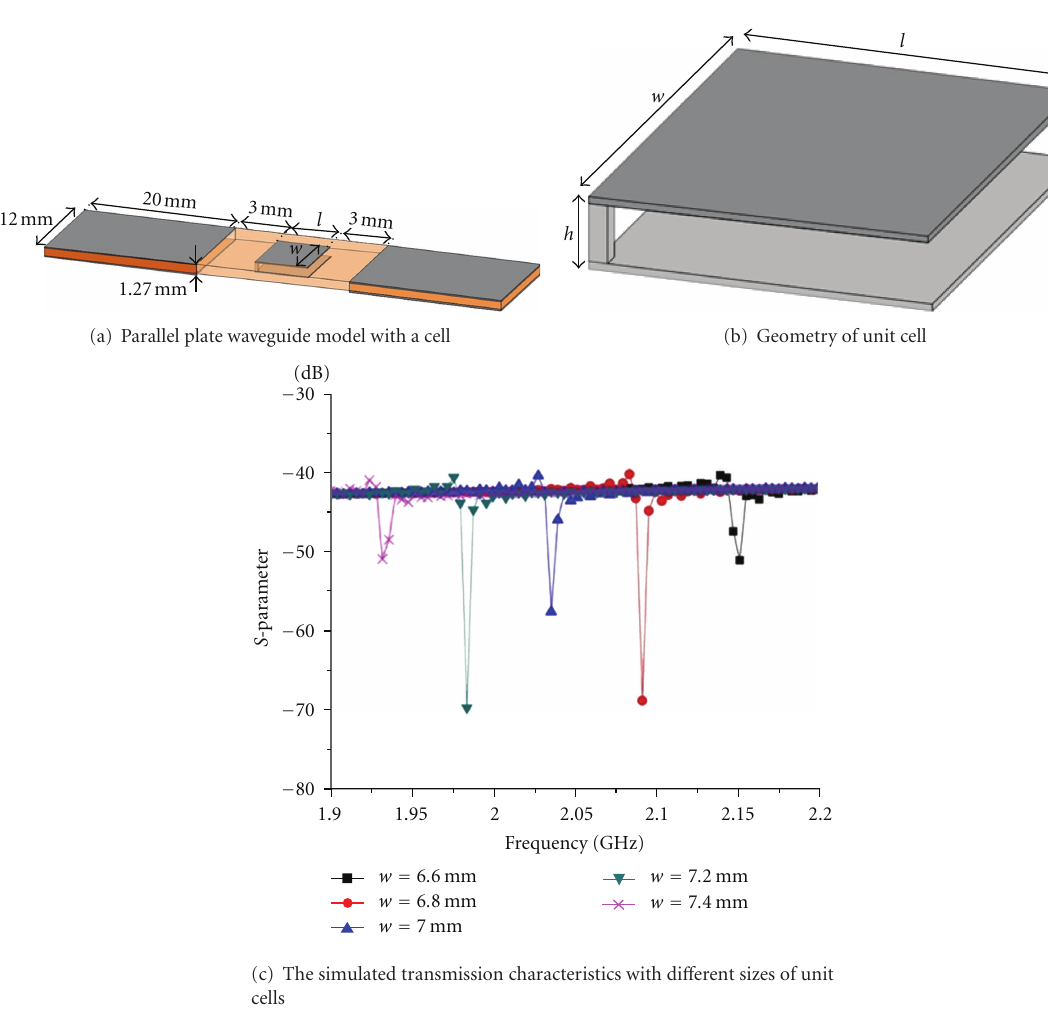
Figure 8: Parallel plate waveguide model with di ff erent sizes of unit